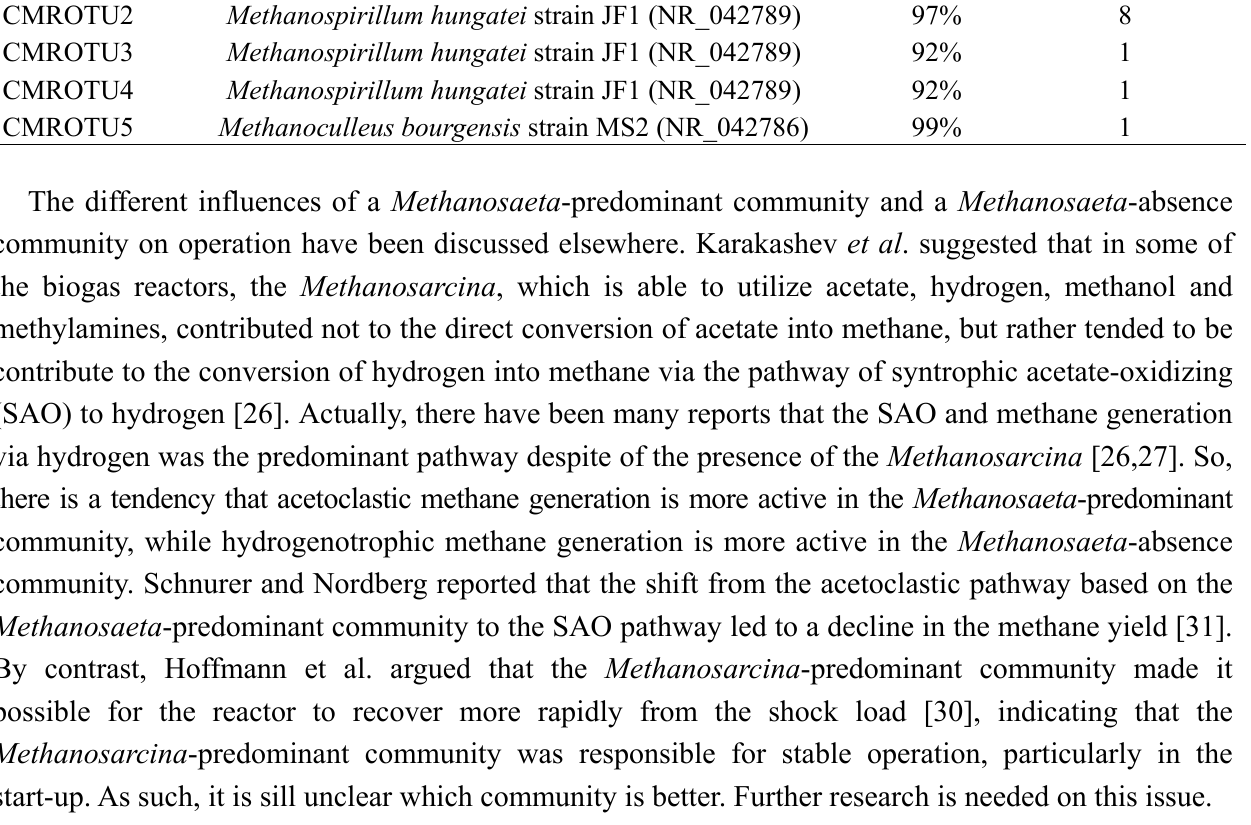
Table 2. Summary of the OTUs obtained from the sludge samples of each reactor investigated. OTU Closest strain (Accession number) Identity Clones obtained SMROTU1 Methanospirillum hungatei strain JF1 (NR_042789) 97% SMROTU2 Methanosaeta concilii strain Opfikon (NR_028242) 99% SMROTU3 Methanosarcina thermophila (NR_044725) 98% UMROTU1 Methanosaeta concilii strain Opfikon (NR_028242)